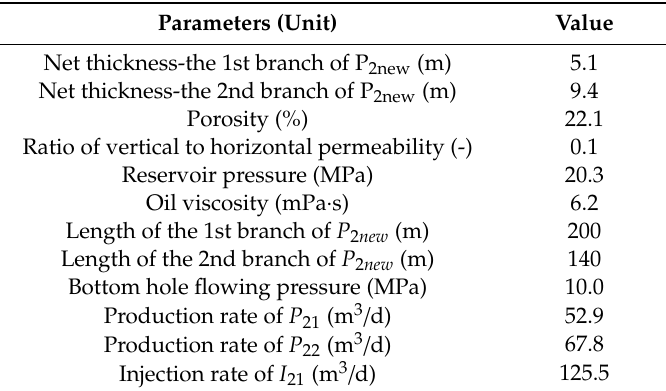
Table 2. Productivity calculation parameters of P 2 new